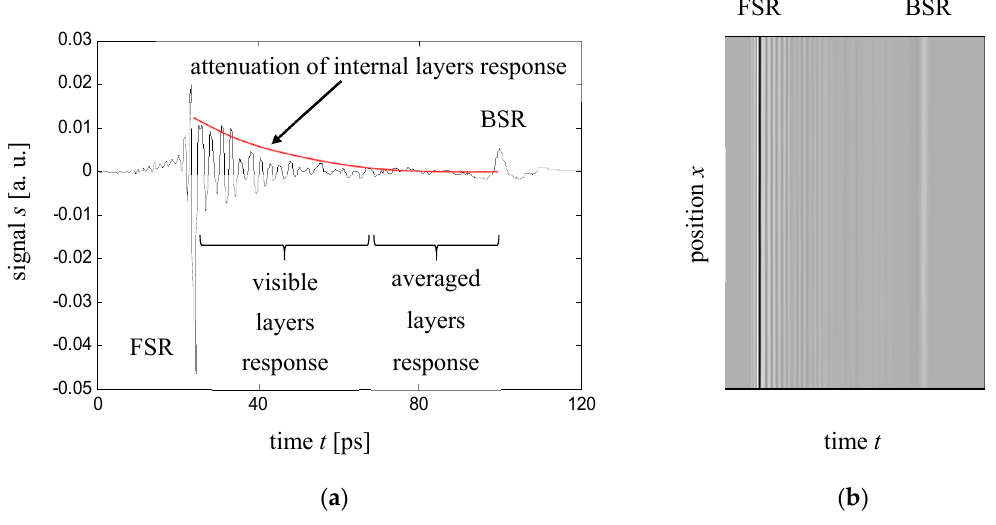
Figure 6. Signals acquired in the case of the inspection of the layered composite material (glass fiber-reinforced) consisting of 30 layers: ( a ) A-scan; and ( b ) B-scan.